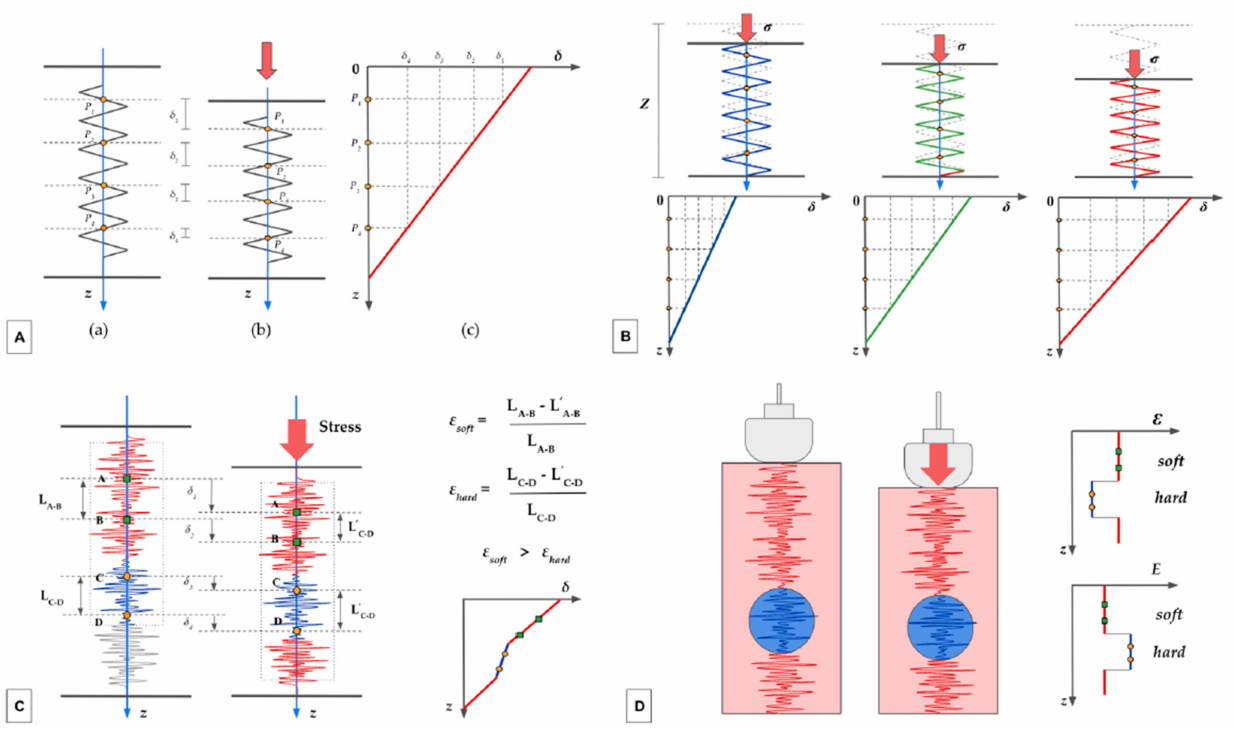
Figure 10. ( A – D ). The autocorrelation